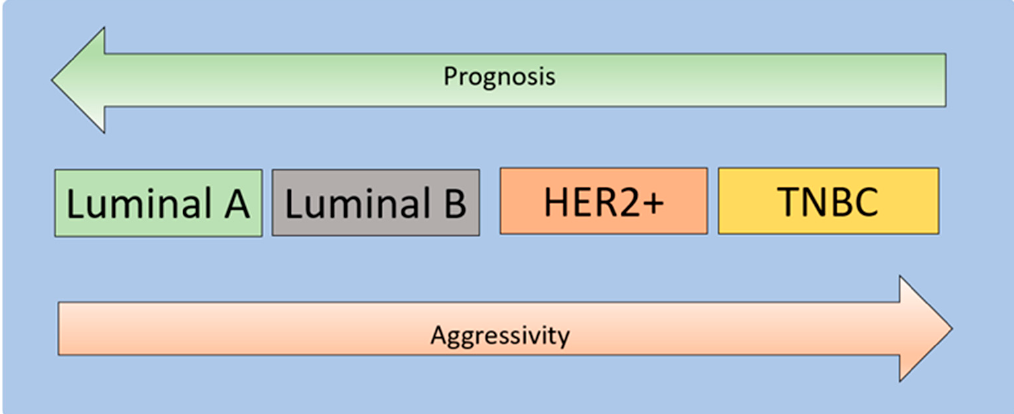
Figure 2. Molecular subtypes of breast carcinoma. BC can be based on hormonal receptors, and HER2 status is divided into luminal types A and B, HER2+, and TNBC [30]. Luminal A and luminal B represent [ER+|PR+]HER2 (tumors with positive ER or PR and negative HER2) and [ER+|PR+]HER2+ subtypes (tumors with positive ER or PR and positive HER2). Luminal A tumors have higher expression of ER-associated genes and lower expression of proliferative genes than luminal B cancers [31,32]. Luminal B tumors tend to have a higher grade than luminal A tumors. The luminal subtype generally carries a good prognosis, and luminal B tumors have a much poorer prognosis than the luminal A subtype [33]. The basal subtype comprises ER-PR-HER2- (triple-negative) tumors with an expression profile that mimics basal epithelial cells from other parts of the body and normal breast myoepithelial cells [34]. This subtype has a low expression of hormone receptors and HER2 and high expression of basal markers and proliferation-associated genes. The tumor has a difficult prognosis, an aggressive clinical course, and currently lacks a standard targeted form of systemic therapy. The pattern of metastases tends to be visceral (excluding bone) and is less likely to involve lymph nodes. Tumors of this class tend to show rapid growth [35].